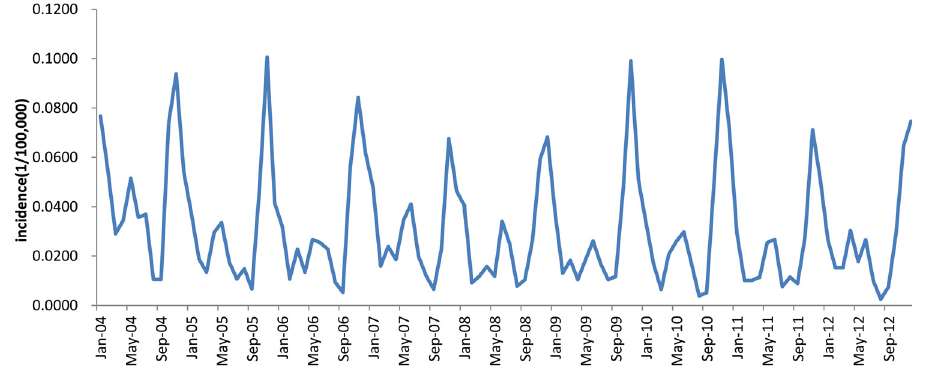
Fig 1. Monthly HFRS incidence series of Jiangsu province in China from January 2004 to December